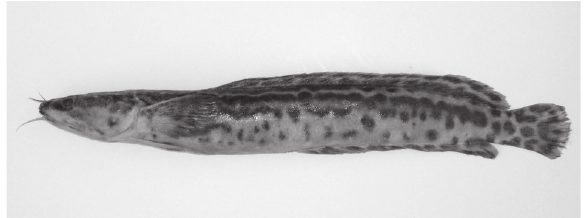
Fig . 2. – Gaidropsarus granti (Regan, 1903). Department of Animal Science, University of Sassari (Italy) ichthyological collection (ref. number DSZ-03/07).